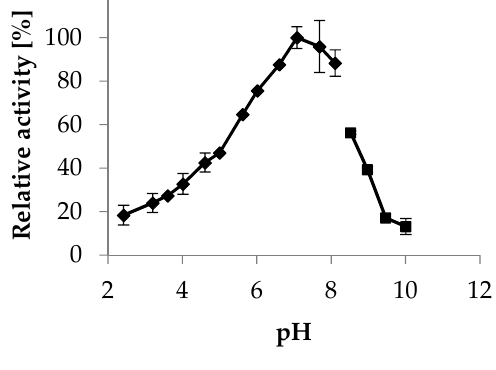
Figure 3. Xylose reductase activity at different pH values. Measurements were taken at 30 °C in a citric acid-disodium phosphate buffer (McIlvaine buffer) [25] ( ◆ pH 2.4–8.1) and 50 mM glycine buffer ( ■ pH